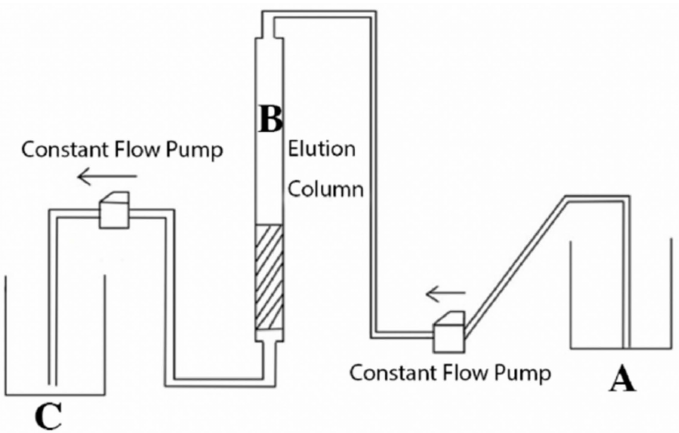
Figure 1. Column adsorption device for removal of phosphorus. A indicates the prepared phosphorus solution, B represents the elution column filled with Al 13 -O-MMt, and C denotes the solution after treatment from Al 13